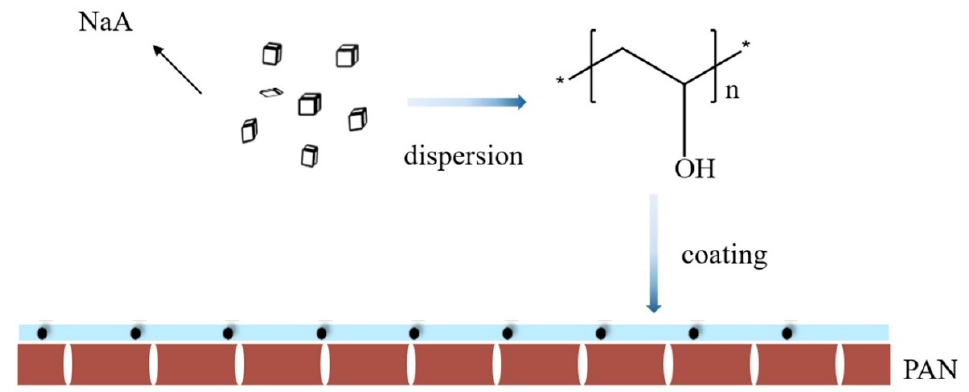
Figure 7. Fabrication procedures of the NaA/PAN